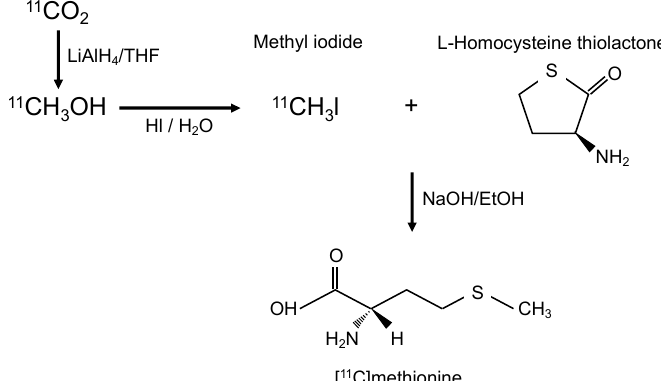
Figure 1. Diagram of synthesis of [ 11 C]methionine. LiAlH 4 = Lithium aluminum hydride, THF = Tetrahydrofuran, HI = Hydroiodic acid